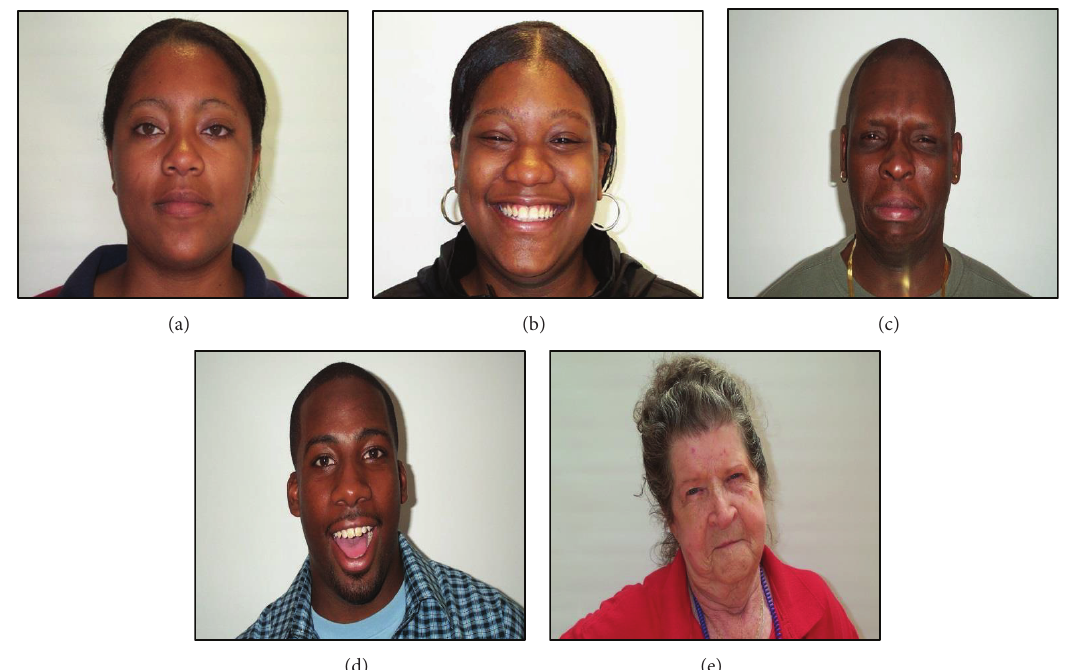
Figure 12: Example images in PAL database with varied genders and facial expressions: (a) female-neutral expression, (b) female-happy expression, (c) male-sad expression, (d) male-surprised expression, and (e) female-annoyed expression.